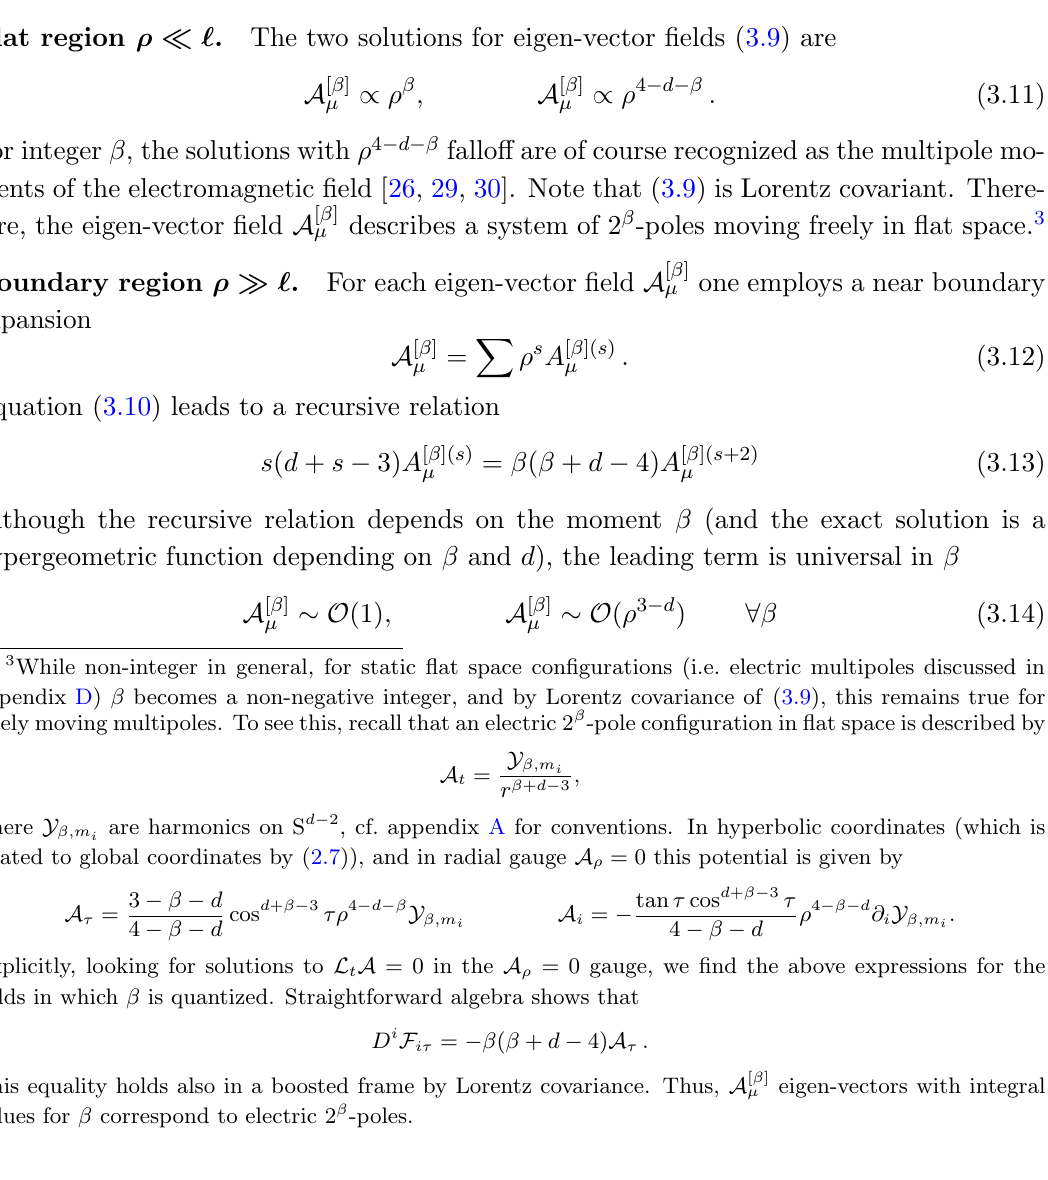
Figure 2 . Displaced and boosted charges. Blue curves show geodesics that cross the origin at t = 0. The paths correspond to di(cid:11)erent Lorentz boosts applied on a static electric charge at the origin. The red curves show two displaced charges, which never cross the origin, or cross it at a later